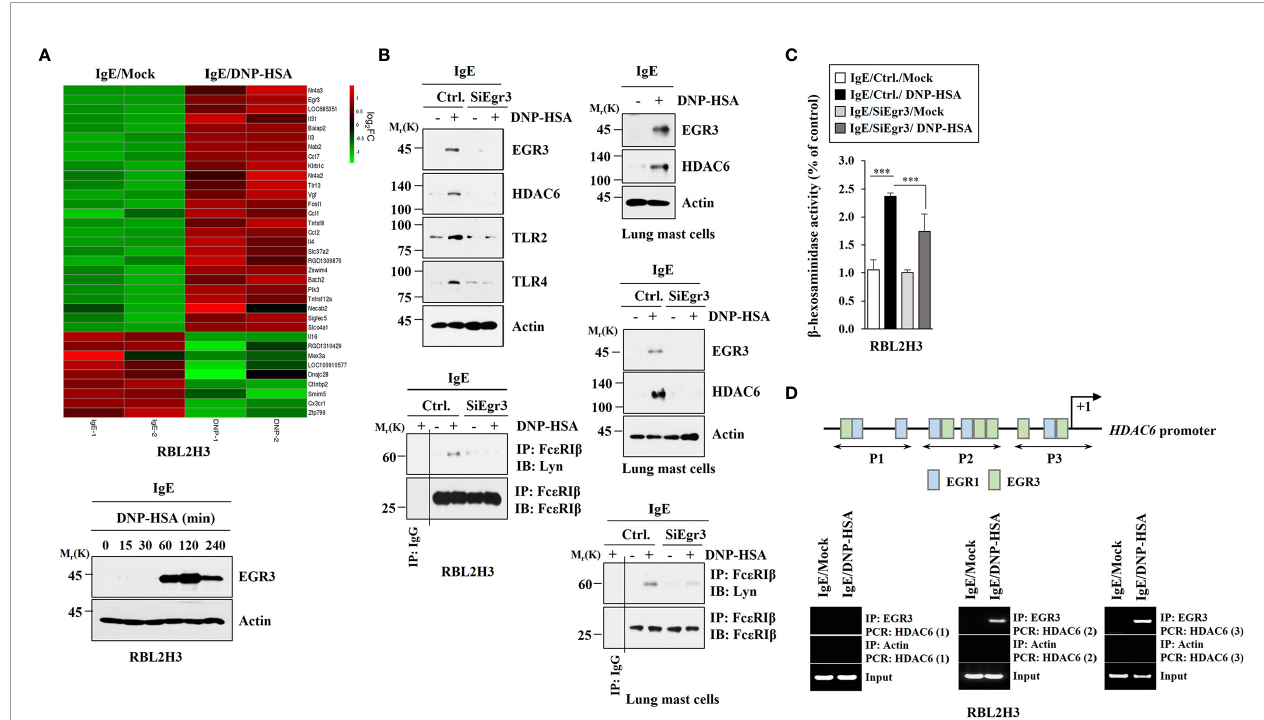
FIGURE 1 | Antigen stimulation increases EGR3 that mediates allergic in fl ammation in vitro and EGR3 binds to the promoter sequences of HDAC6. (A) The DNP- speci fi c IgE-sensitized RBL2H3 cells were treated without or with DNP-HSA (100 ng/ml) for 1 h. Total RNAs were subjected to RNA sequencing analysis (upper panel). RNA sequencing analysis represents replicates within one experiment. Cell lysates prepared at each time point were subjected to immunoblot (lower). Representative blots of three independent experiments are shown. (B) The indicated siRNA (each at 10 nM) was transfected into RBL2H3 cells (left) or lung mast cells (right). At 24 hours after transfection, cells were sensitized with IgE for 24 h, followed by stimulation with DNP-HSA for 1 h. Ctrl. denotes negative control siRNA. The IgE-sensitized lung mast cells were stimulated with DNP-HSA for 1 h (upper, right). Immunoblot and immunoprecipitation were performed. Immunoprecipitation using isotype-matched IgG antibody (2 m g/ml) was also performed. Representative blots of three independent experiments are shown. (C) The b -hexosaminidase activity assays were performed in RBL2H3 cells. *** p <0.001. Average values of three independent experiments are shown. (D) ChIP assays were performed in RBL2H3 cells treated without or with DNP-HSA (100 ng/ml) for 1 h. P1, P2, and P3 denote primer-binding sites. Anti-actin antibody served as a control